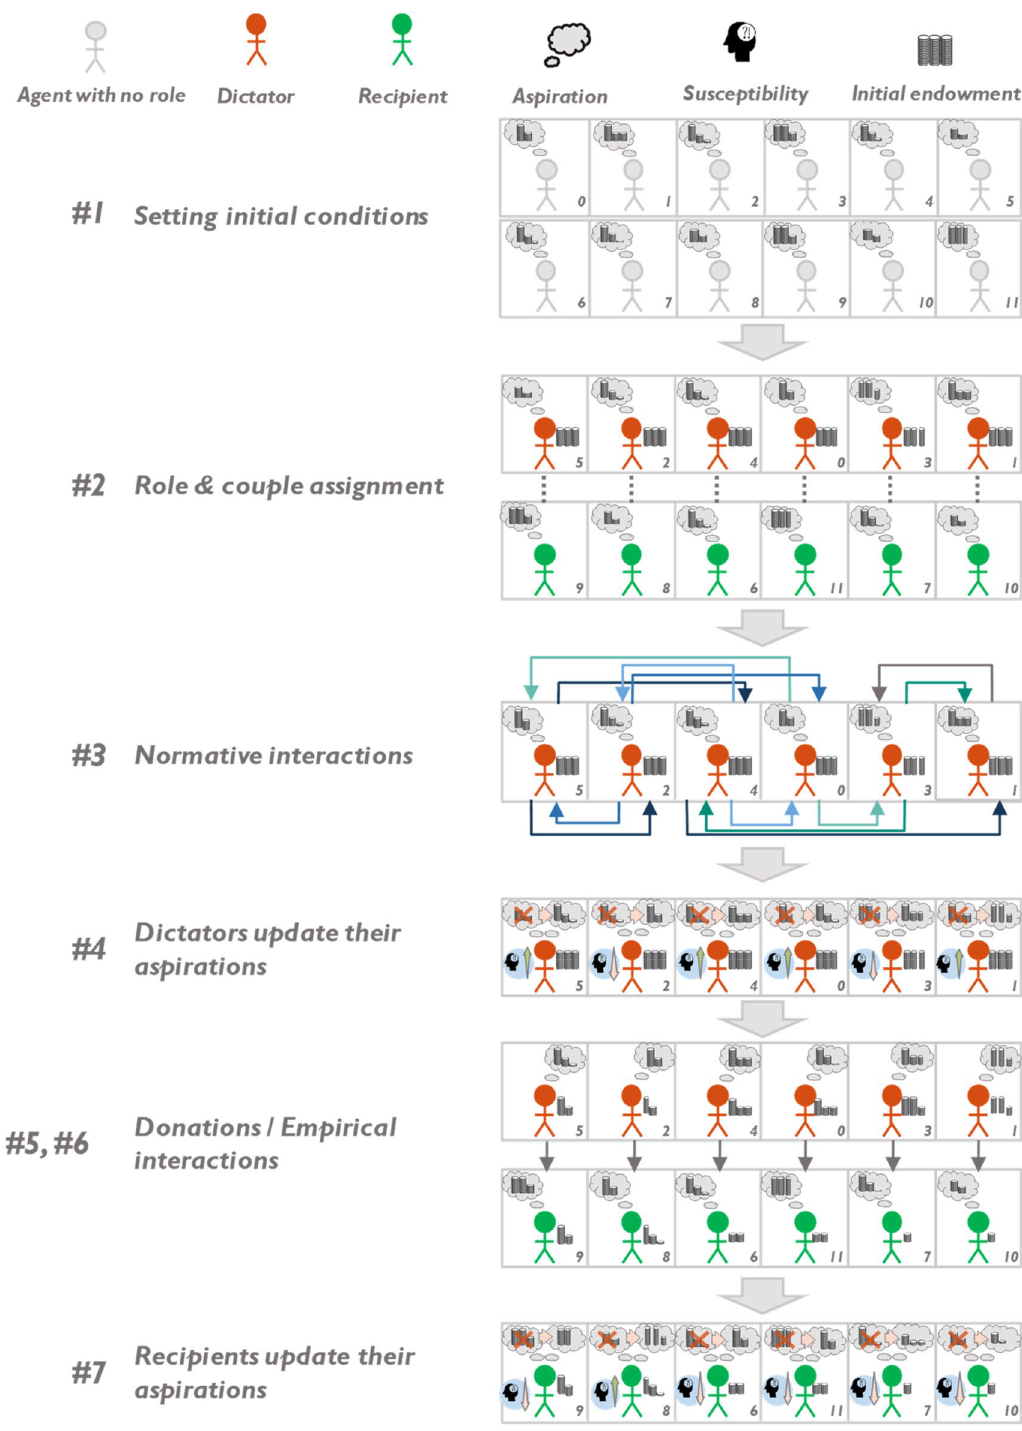
Figure 1. Visual representation of the different phases of the model, for a value Q = 2, shown by the number of arrows coming out and from each dictator in step